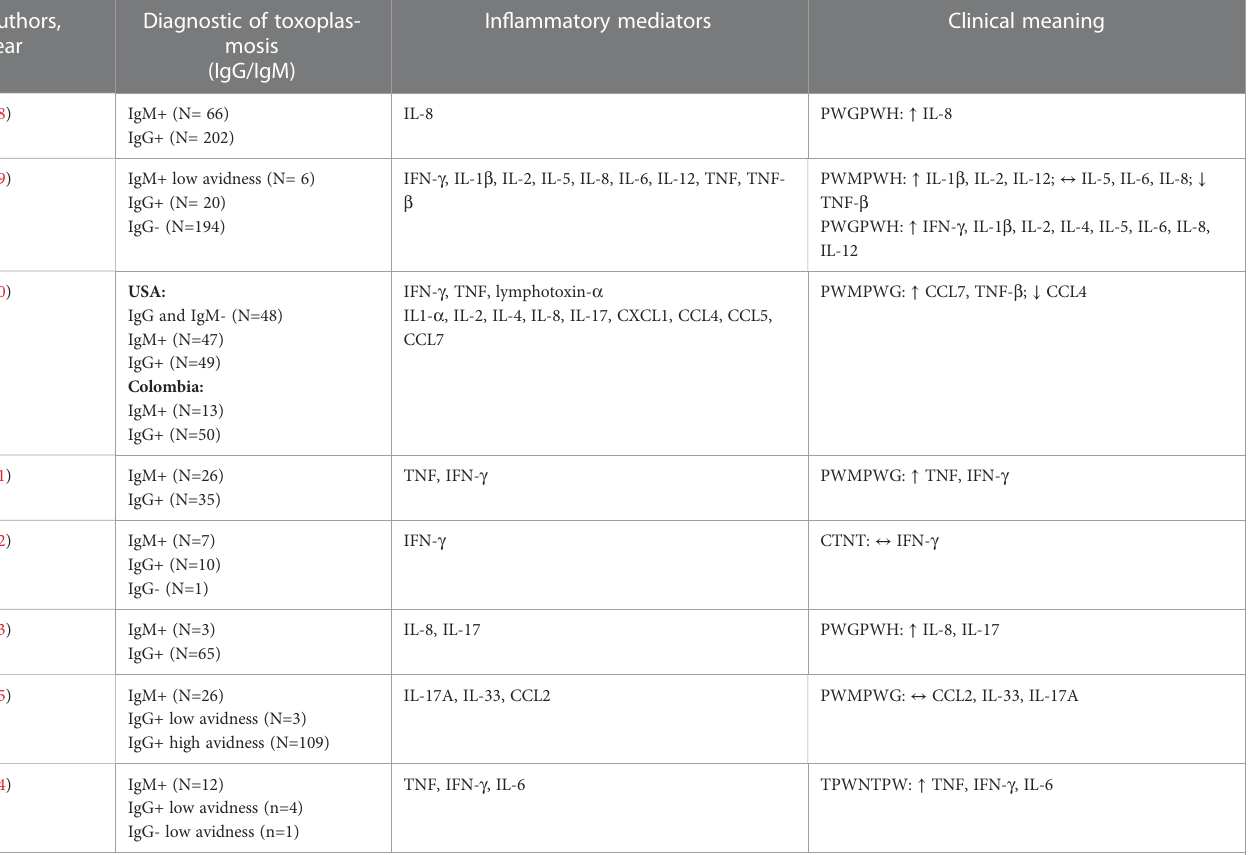
TABLE 2 In fl ammatory mediators in T. gondii -infected pregnant women